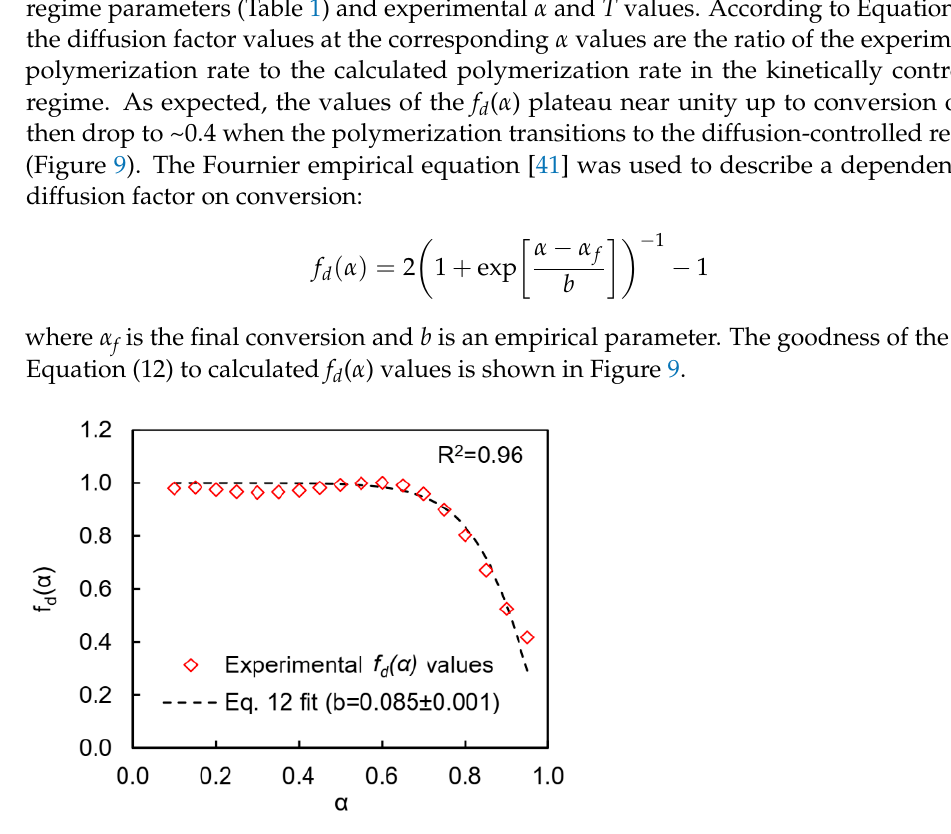
Figure 10. Comparison of the experimental polymerization rate curves (triangles) with those estimated with (solid line) and without (dashed line) accounting for diffusion control. It is instructive to compare the reactivity of the presently synthesized rigid tricyanate ester with other cyanate esters of lower functionality that contan flexible bridging units. The transition of the polymerization from a kinetic- to a diffusion-controlled regime is of particular interest. As previously mentioned, polymerization of the presently studied tricyanate ester transitions to the diffusion-controlled regime at α ≈ 0.7. In turn, non- catalyzed polymerization of dicyanate esters with flexible bridging units does not show such transition under non-isothermal conditions, which means that reaction proceeds in a kinetically controlled regime in the whole conversion range [20,30,34]. The thermal stability and glass transition temperature of the polymerization product were evaluated by TGA and TMA (Figure 11). Thermal decomposition of cyanate polymers is known to be a complex process. This complexity manifests itself in the multi- step character of the mass loss that reveals the presence of three large peaks (463, 640, and